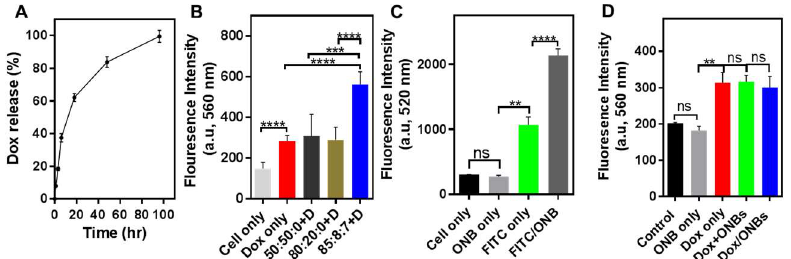
Figure 3. Drug release and cell penetration of the drug / ONB conjugates. ( A ) The drug release profile of Dox from Dox / ONB conjugates. ( B ) Cell penetration of the Dox + ONB mixture in MDA-MB-231 cells. Various lipid ratios (1,2-distearoyl-sn-glycero-3-phosphocholine (DSPC), 1,2-distearoyl-sn-glycero-3-phosphoethanolamine-N-[amino(polyethylene glycol)-2000] (DSPE-PEG-2000-Amine), and DSPE-PEG-2000-Biotin) were used to synthesize ONBs to assess their penetration effect, and were evaluated using the fluorescence intensity of Dox. ( C ) Cell penetration of FITC-conjugated ONBs in MDA-MB-231 cells evaluated using the fluorescence intensity of fluorescein (FITC) ( D ) Cell penetration of Dox/ONB was evaluated and compared to those of Dox only and Dox + ONB mixture in MDA-MB-231 cells. * indicates p -value < 0.05, ** indicates p -value < 0.01, *** indicates p -value < 0.001, and **** indicates p -value < 0.0001. ns: no significant difference.